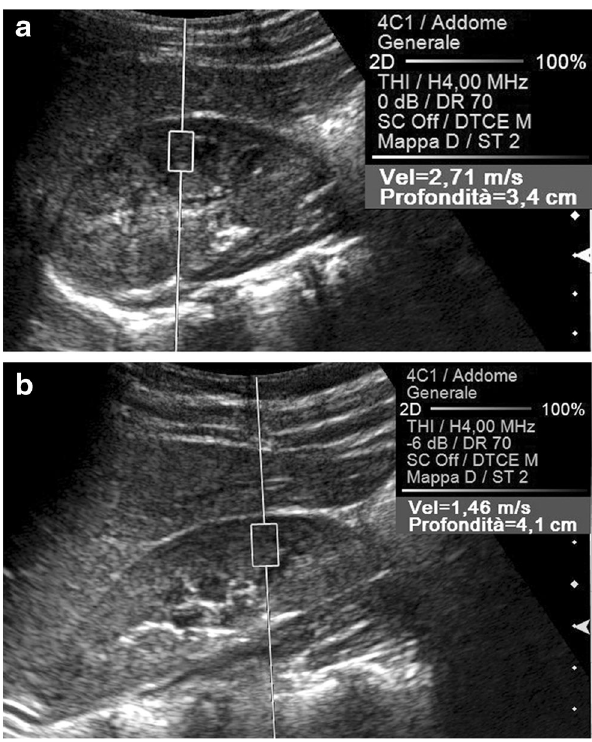
Fig. 5 Effect of the source-to-target distance on the speed of propagation oftheshearwaves.ObliqueUSscansonthe rightkidneyin a healthy, thin subject. A higher SWV value (2.71 vs. 1.46 m/s) is measured in the renal cortex using a posterior approach ( a ), in which the kidney is closer to the skin surface, compared to using an anterior approach ( b )